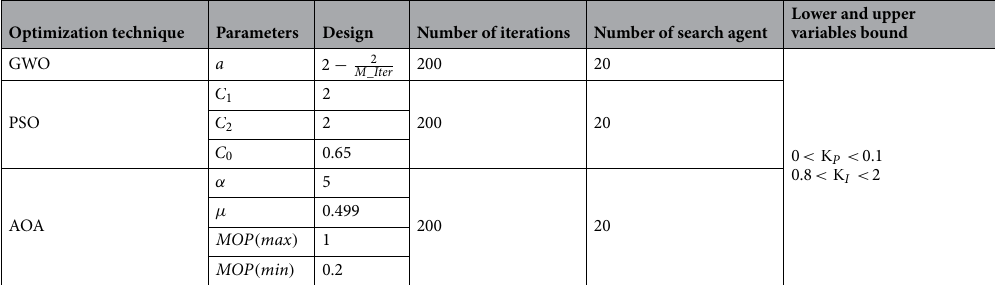
Table 2. Parameters of optimization algorithms.